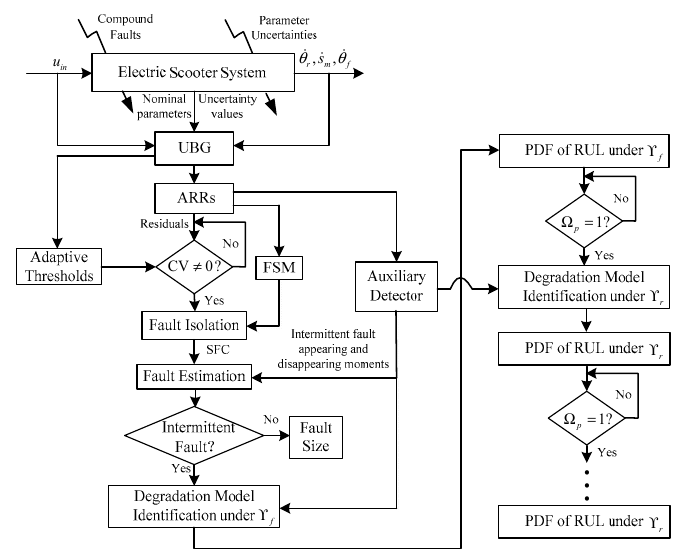
Figure 4. Flow chart of the proposed method.